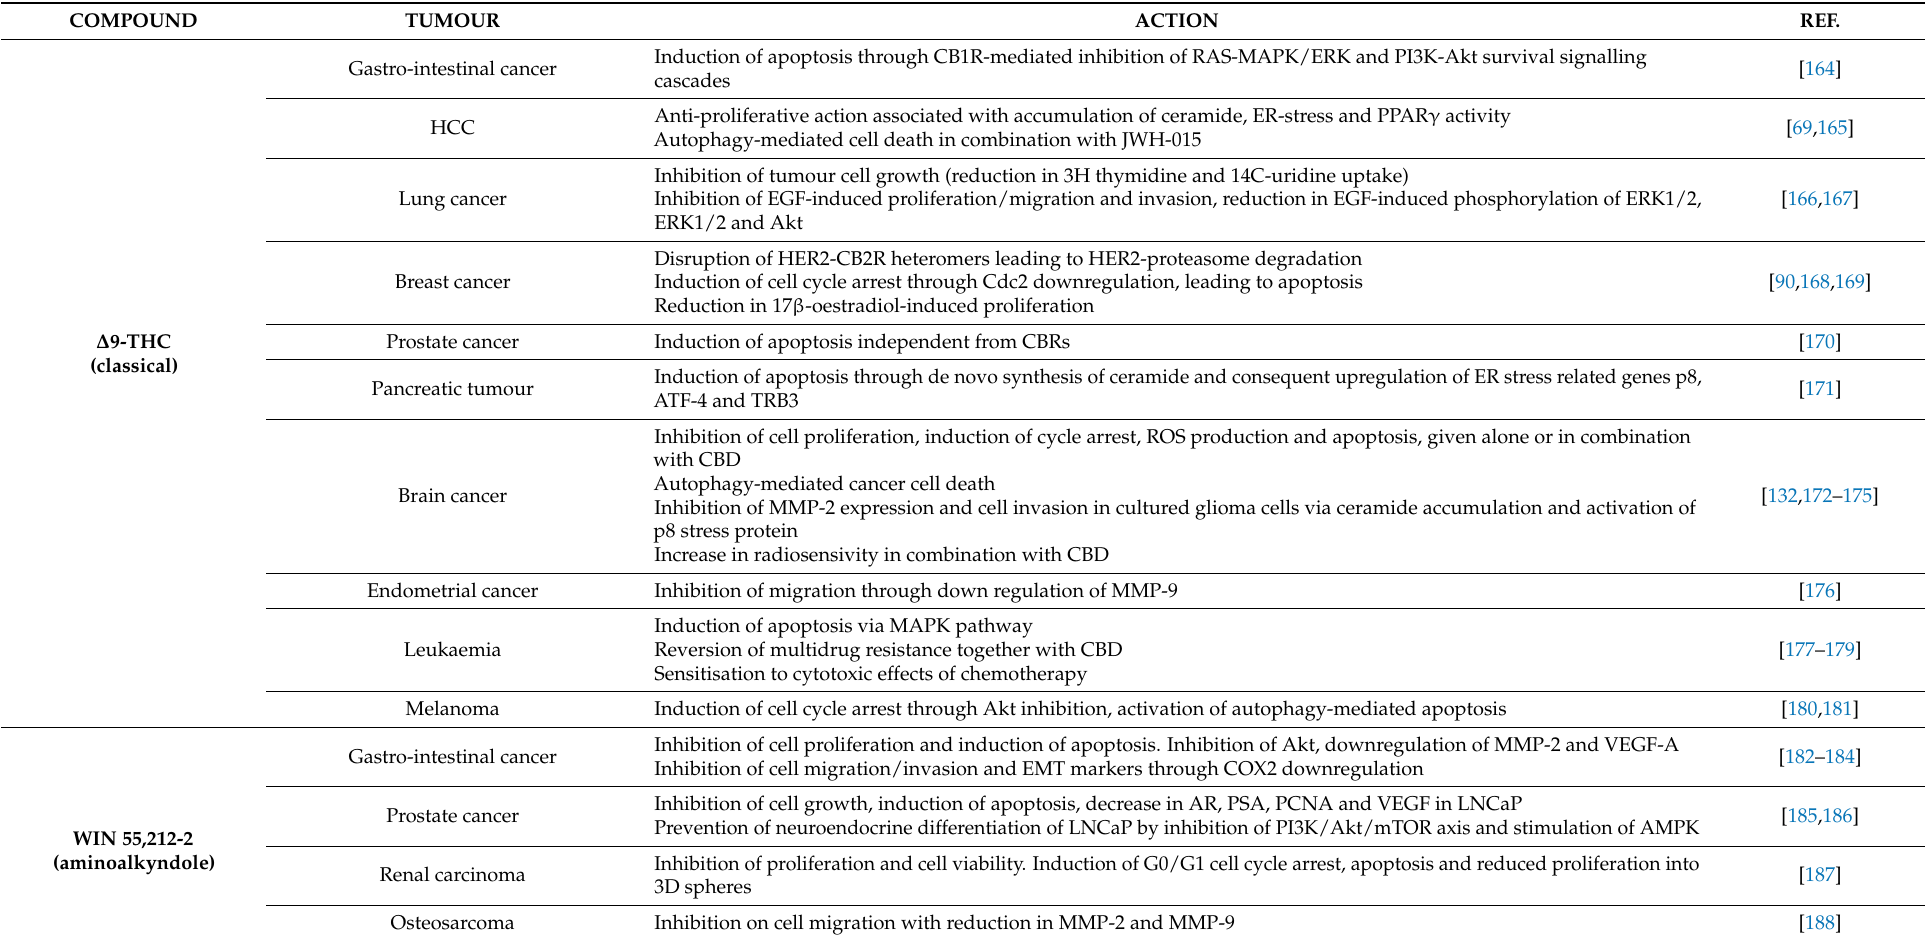
Table 2. In vitro evidence of the main cannabinoid receptor agonists in different tumour